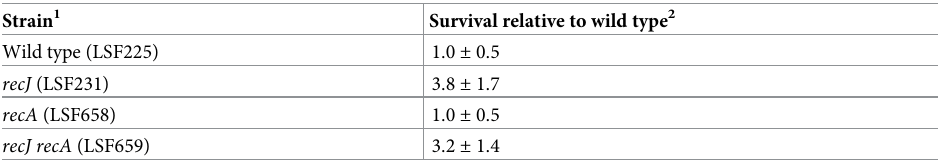
Table 2. recA is not needed for increased survival to replication stress in the absence of recJ